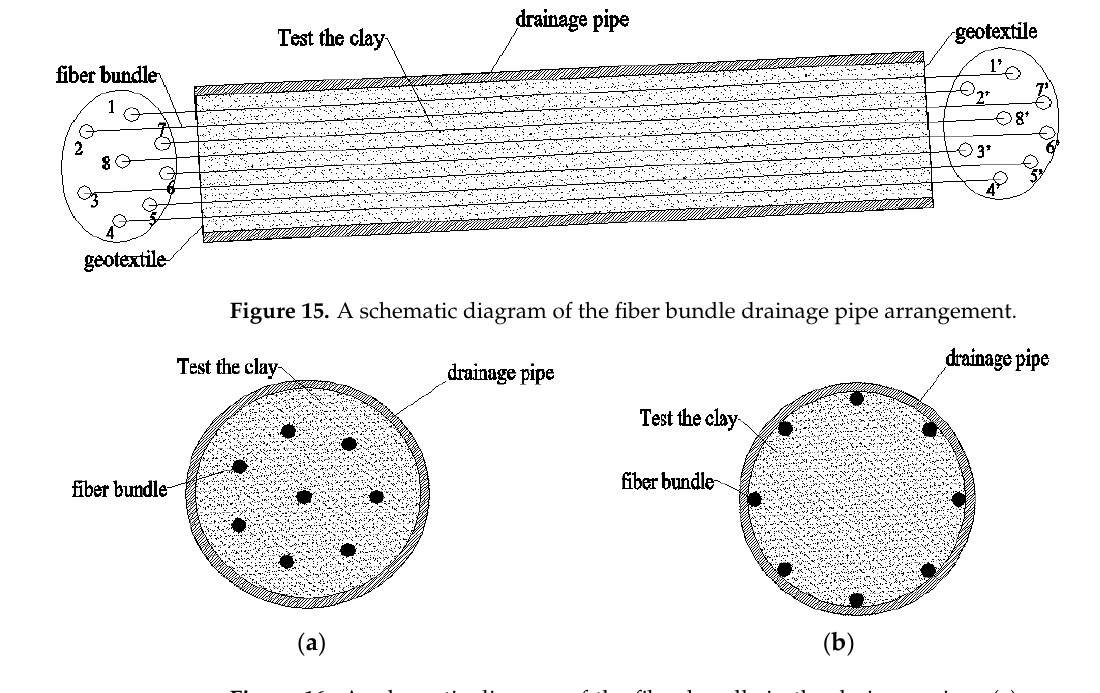
Figure 16. A schematic diagram of the fiber bundle in the drainage pipe. ( a ) even arrangement. ( b ) uneven arrangement.